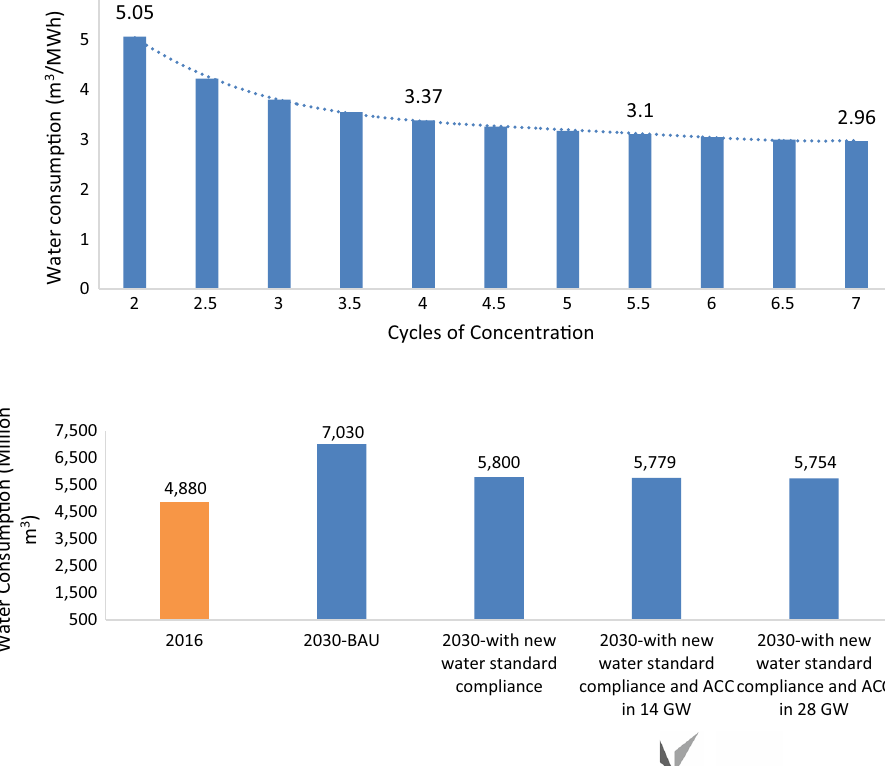
Fig. 4 Total water consumption in 2030 under various